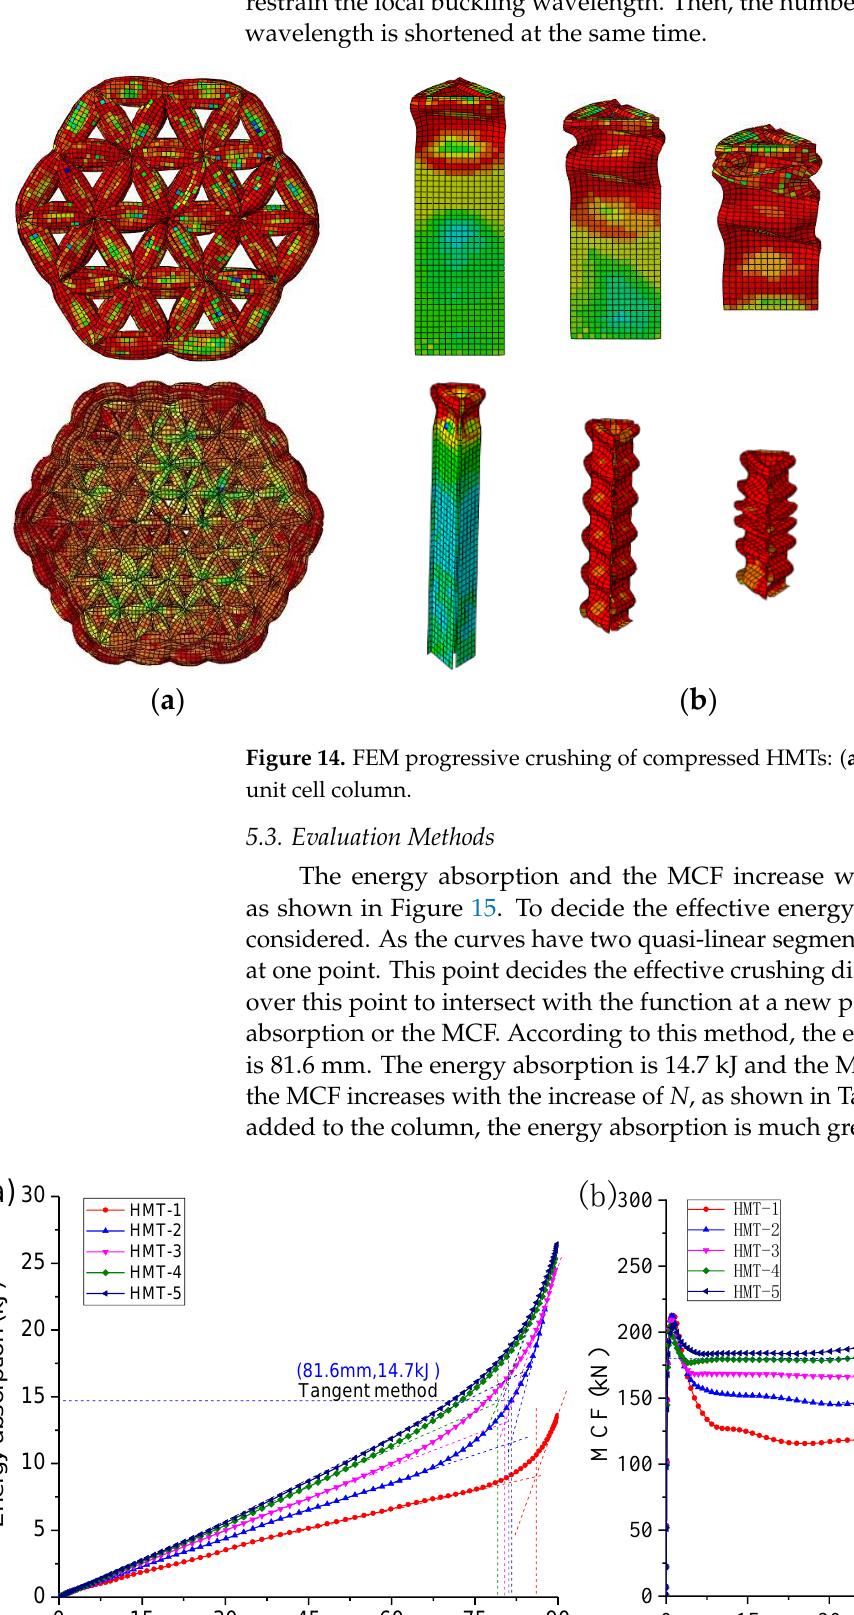
Figure 13. The crushing performance of multi-cell thin wall tube: ( a ) force – displacement curves, ( b ) energy absorption parameters curves, and ( c ) folding modes.